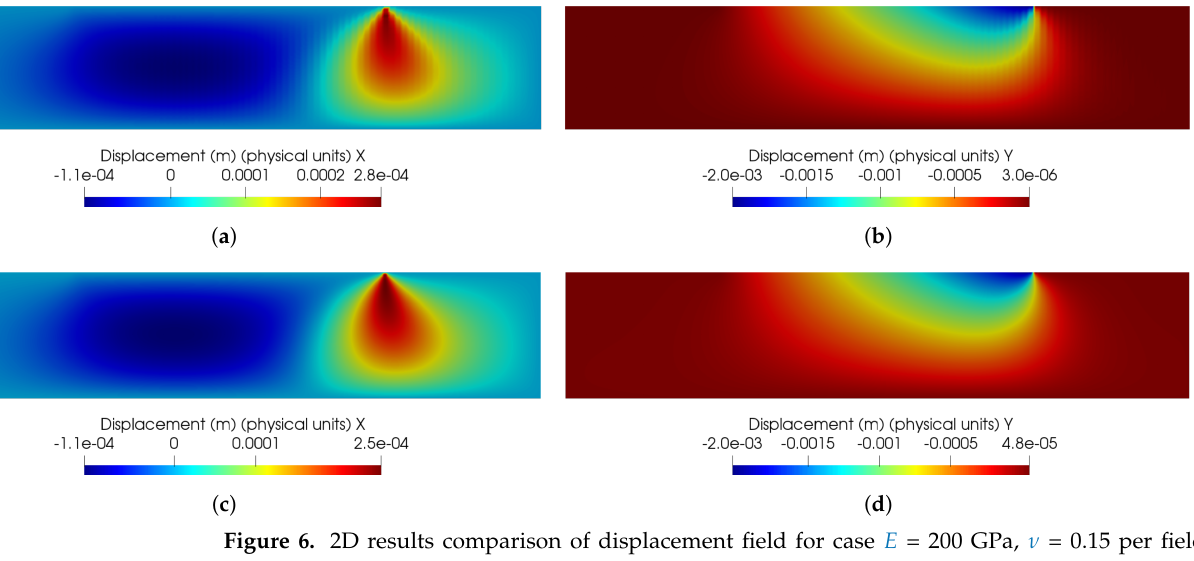
Figure 6. 2D results comparison of displacement field for case E = 200 GPa, ν = 0.15 per field component and with a triangular loading profile. ( a ) Displacement along X axis, with LBMS. ( b ) Dis- placement along Y axis, with LBMS. ( c ) Displacement along X axis, with COMSOL. ( d ) Displacement along Y axis, with COMSOL.